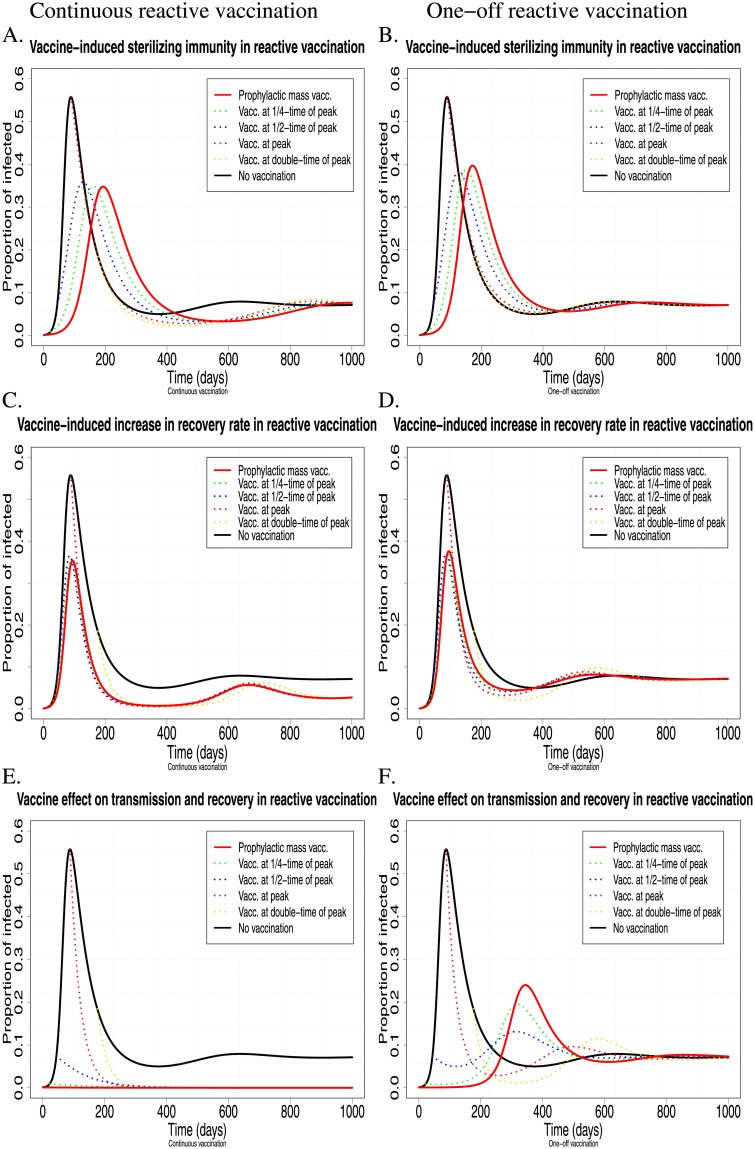
The effect of complete mass vaccination (i.e. p = 1) with vaccines of different properties on the infection dynamics in the case of continuous (left column) and one-off (right column) reactive vaccination.Profiles of different colours correspond to different times when vaccination is applied, i.e. (i) at the start of the epidemic, equivalent to prophylactic vaccination (red continuous curves), (ii) at one quarter of the time of peak prevalence (green dotted curves), (iii) at one half of the time of peak prevalence (blue dotted curves), (iv) at the time of peak prevalence (red dotted curves), (v) at double the time until peak prevalence (gold dotted curves) and when (vi) vaccination is not applied at all (black continuous curves). A.-B. The vaccine only affects host susceptibility, i.e. sterilizing immunity, but no effect on infectivity or recovery (ϵs = 0.5, ϵγ = ϵi = 0) (see relations (7) and (10)); C.-D. The vaccine only speeds up recovery, but offers no protection from infection and no reduction in infectivity (ϵγ = 0.5, ϵs = ϵi = 0) (see Eqs (9) and (10)); E.-F. The vaccine equally affects host susceptibility, infectivity and recovery rate, ϵ = ϵs,i,γ = 0.5 (see Eqs (7)–(9) and (10)). Here βNN = 0.12, γN = 0.01785, p = 1, d = 0.001, μ = 0.0017, and the initial conditions are SN(0) = 0.999, IN(0) = 0.001 (see relation (11) for p = 0 and I0 = 0.001).